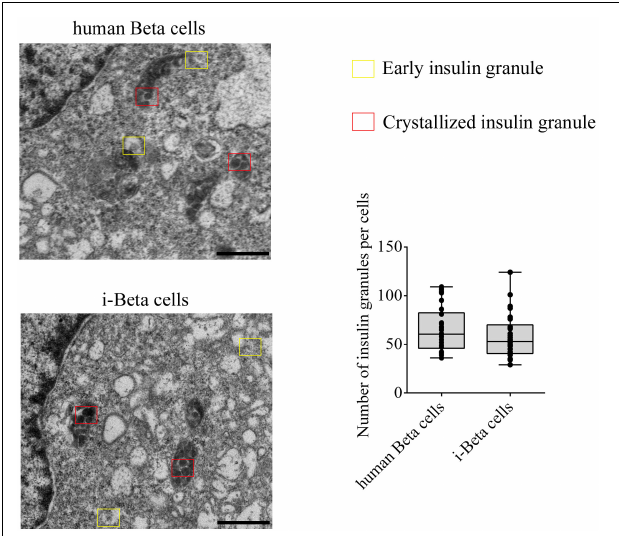
FIGURE 2 | Electron microscopy of granules in sectioned cells with representative crystallized insulin granules (red) and early insulin granules (yellow) in human beta cells and i-Beta cells. Left panel shows electron microscopy images of granules in human beta cells (top image) and i-Beta cells (bottom image). Right panel shows a box and whisker plot of the number of insulin granules per cell ( n = 20, Scale bar = 1 µ m).